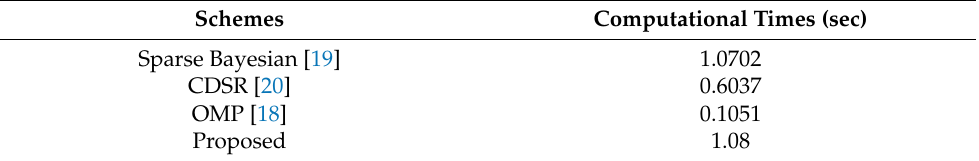
Figure 13. RMSE vs. SNR with M = 4.